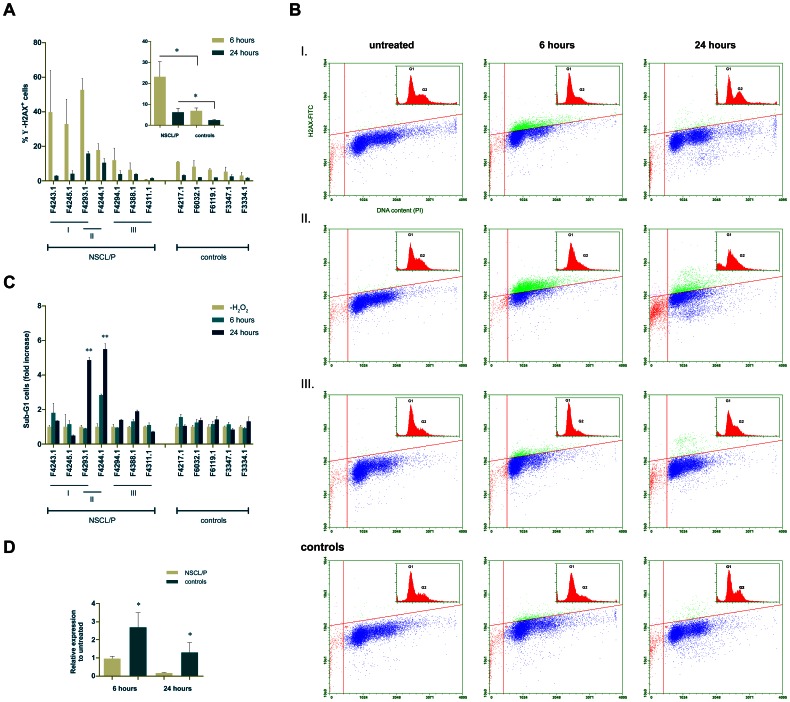
NSCL/P cells exhibit a heterogeneous response to H2O2, with distinct patterns of DSB accumulation.(A) Smaller graph - Comparison of the fraction of γ-H2AX+cells between NSCL/P and control cells, at 6 and 24 hours of treatment with H2O2. Large graph – Individual quantitation of γ-H2AX+ cells, revealing the subgroups (I–III) within the NSCL/P samples. (*) p<0.05. (B) Representative γ-H2AX and PI profiles depicting DSB and cell cycle distribution, for each NSCL/P subgroup and controls. (C) Quantitation of sub-G1 cells, revealing a significant increment in NSCL/P subgroup II, at 24 hours of treatment, as compared to the other subgroups and the controls. (**) F = 6.04; p<0.005. (D) Relative expression of CDC45L following treatment with H2O2, revealing a significant decrease in NSCL/P samples at both time points, by comparison to controls. (*) p<0.05.